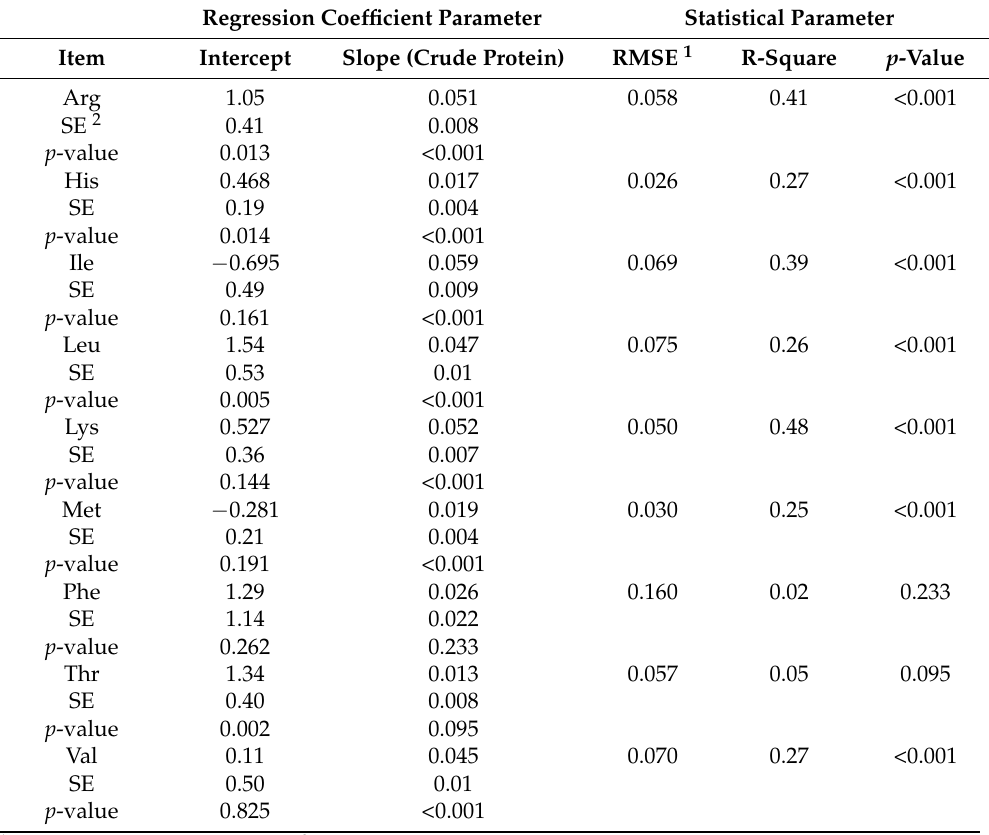
Table 4. Simple linear regression equations to predict indispensable amino acids (% on a dry